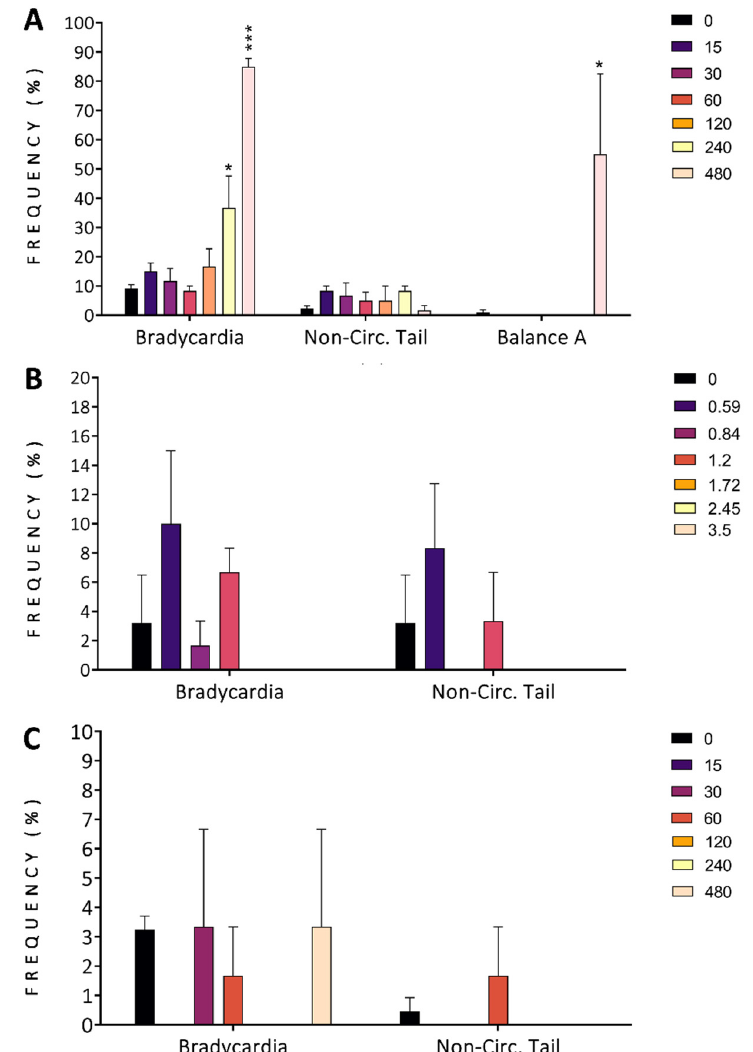
Figure 4. Morbidity assessments of zebrafish development for the whole organism exposed at 96 h post-fertilization to different concentrations of finger lime ( A ), mountain pepper ( B ), and tamarind ( C ). In ( C ), bradycardia is represented for groups exposed to tamarind. Non-Cir. Tail = non-circulation (of blood) in the tail; Balance A = balance alteration. Colours in ( A , B ) represent the concentrations tested (mg/L). Data represent the mean ± SD, n = 60. Asterisks indicate statistical significance when comparing the exposed groups with the control groups: p < 0.05 (*) and p < 0.001 (***).